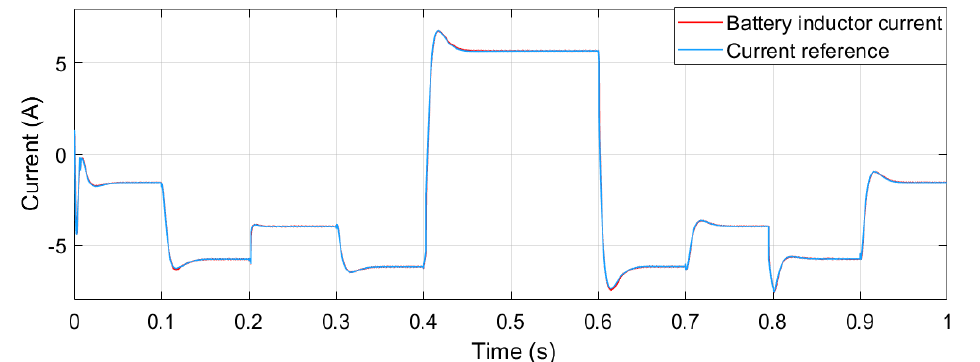
Figure 12. DC bus voltage.